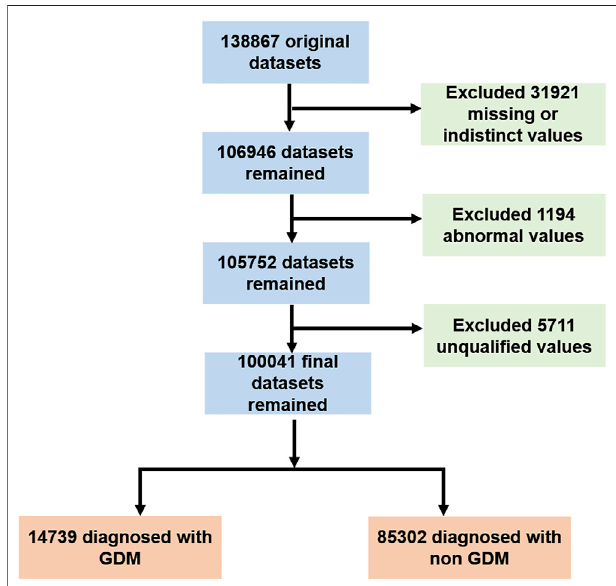
FIGURE 1 | Selection of the study